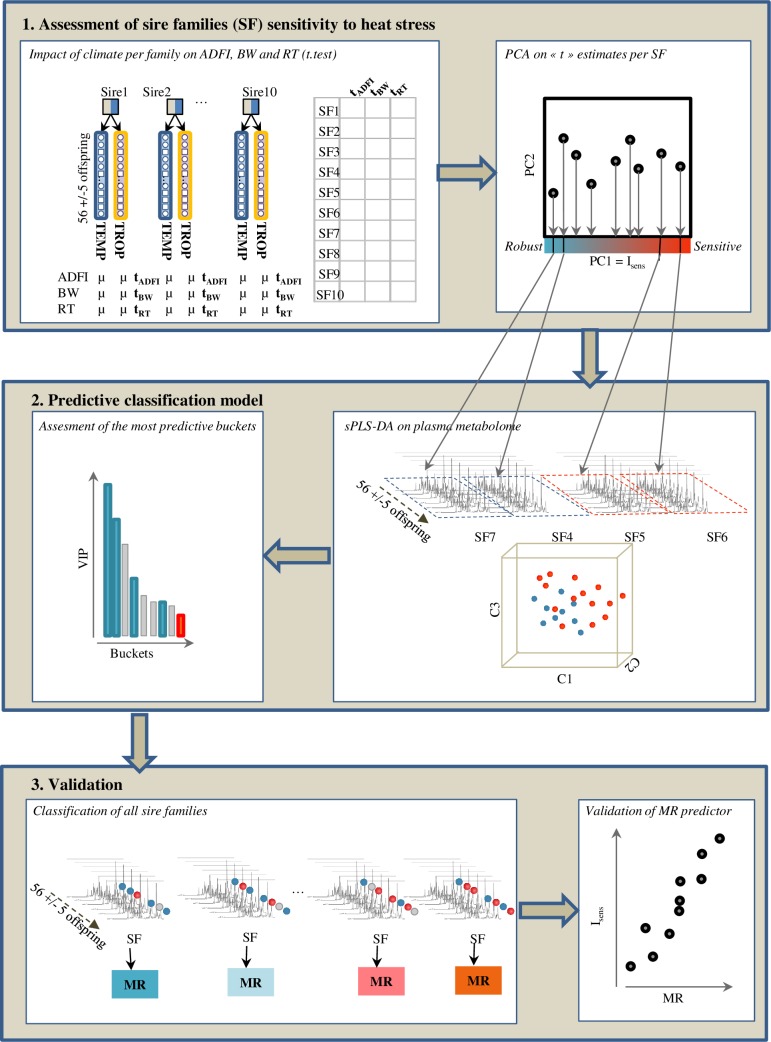
Statistical workflow.Statistical approach that lead to: 1) assess sensitivity of each SF to TROP climate according to a composite index of sensitivity (Isens) that took into account the between-climate variations of average daily feed intake (ADFI), body weight (BW) at 23 weeks and rectal temperature (RT) at 23 weeks, 2) Build a supervised classification model on metabolomic data between the robust and climate sensitive groups by sPLS-DA, 3) predict the membership rate (MR) of the other SF to the sensitive group using sPLS-DA. The relevance of MR interpretation as predictive index of sensitivity was confirmed through its highly significant correlation with index of sensitivity (Isens).